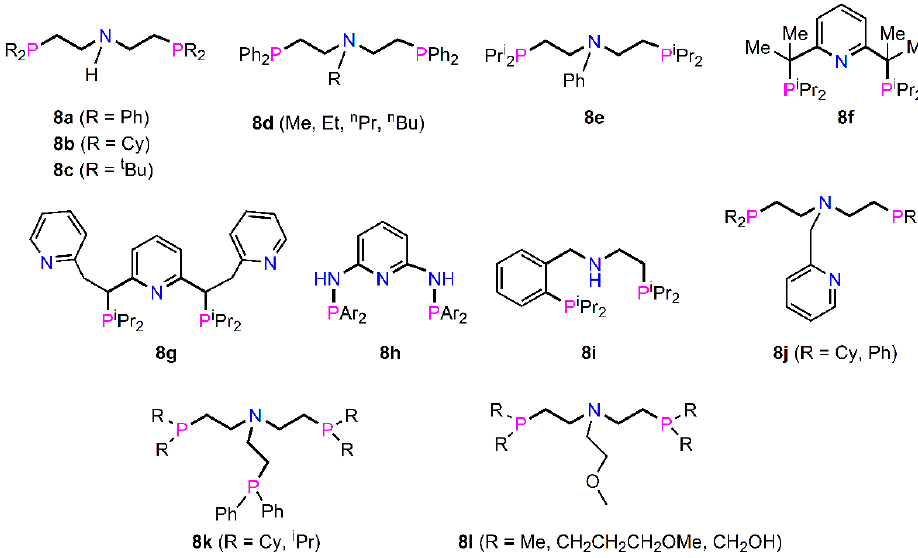
Figure 11. Selected examples of P–C–C–N–C–C–P diphosphines and related analogues.